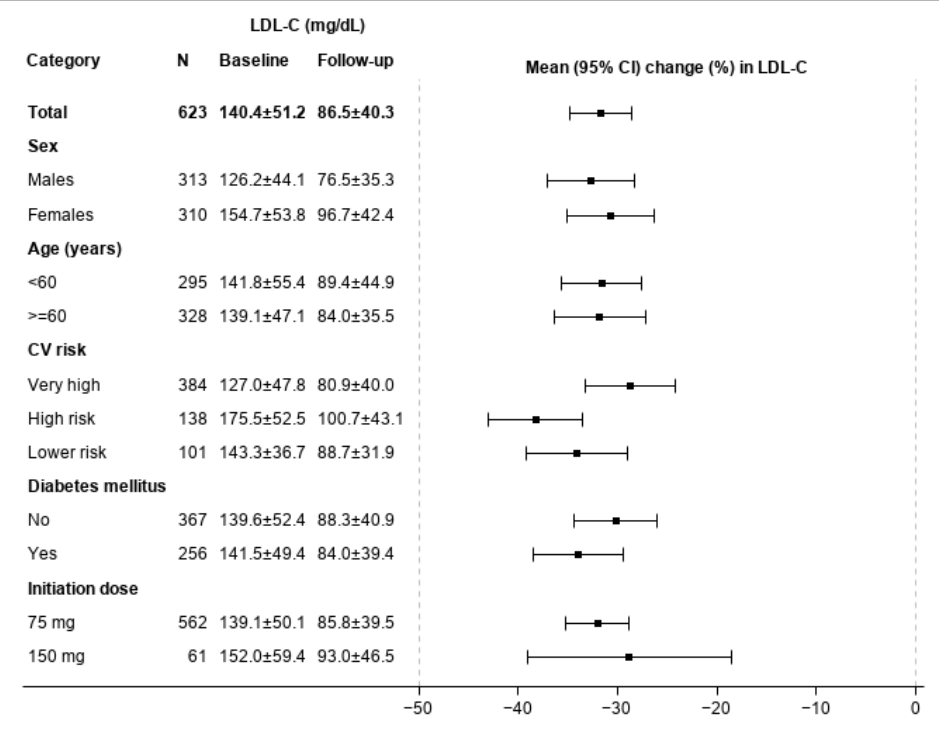
Figure 2. Percentage change in LDL-C within 120 ( ± 60) days from PCSK9- i treatment initiation. If LDL-C could not be calculated during the baseline or follow-up period as a result of high triglyceride levels, then non-HDL-C was used instead. The baseline and follow up LDL-C in the graph are LDL-C (or non-HDL-C minus 30 if LDL-C could not be calculated). p -values for percentage change in LDL-C (or non-HDL-C when LDL-C could not be calculated) were calculated by using the Wilcoxon sign rank and were all lower than 0 ( p < 0.001). Within group differences were tested using Wilcoxon sum rank test and the Kruskal–Wallis test for comparisons of two categories and more than two categories, respectively. All p-values between groups were higher than 0.1 in all subgroups.